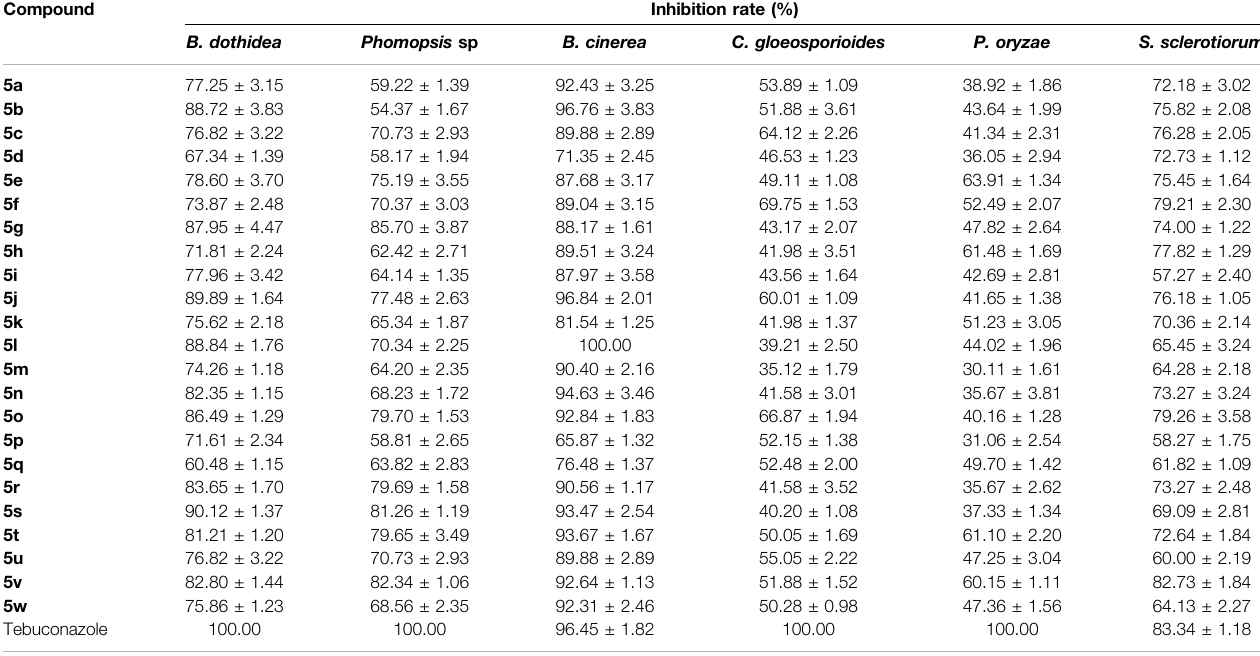
TABLE 1 | The antifungal activities of the title compounds 5a − 5w at 50 μ g/ml. Compound Inhibition rate (%)